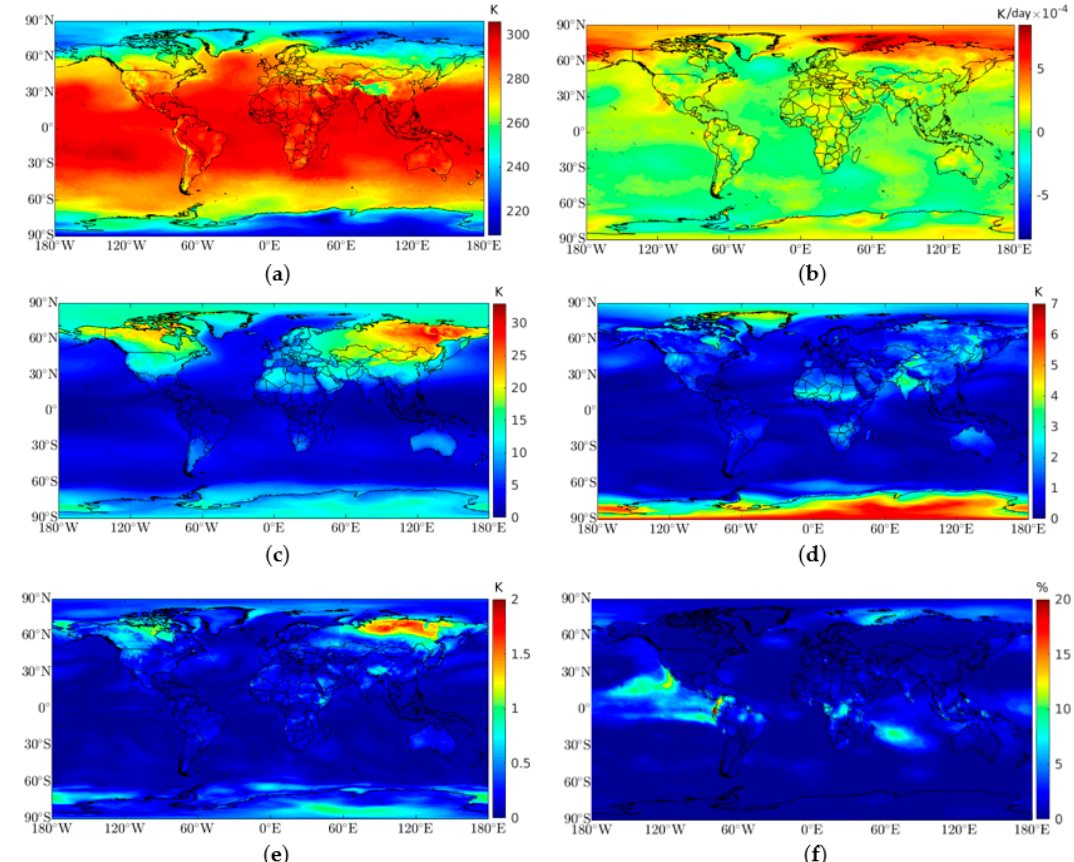
Figure 1. Global distribution of mean coe ffi cients for surface air temperature. The globe was divided into a 0.25 ◦ × 0.25 ◦ grid. ( a ) a mean values (K), ( b ) b mean values (trend) (K / day), ( c ) mean annual amplitude contribution (K), ( d ) mean semi-annual contribution (K), ( e ) mean quarterly contribution (K); and ( f ) mean impact of introducing a linear trend versus using only the mean temperature, in